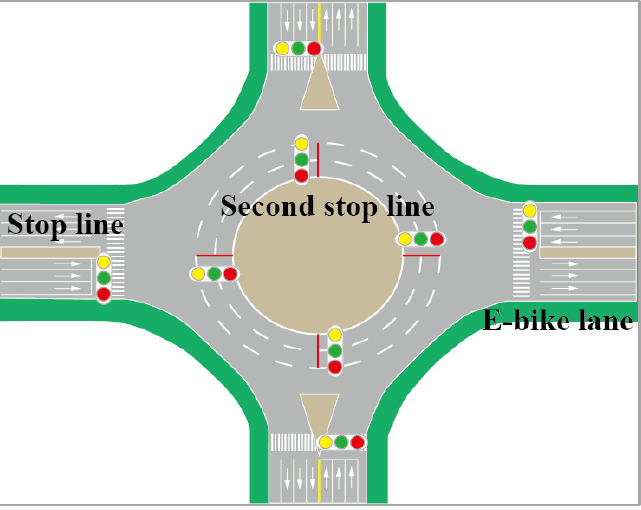
Figure 1. The conventional roundabout.